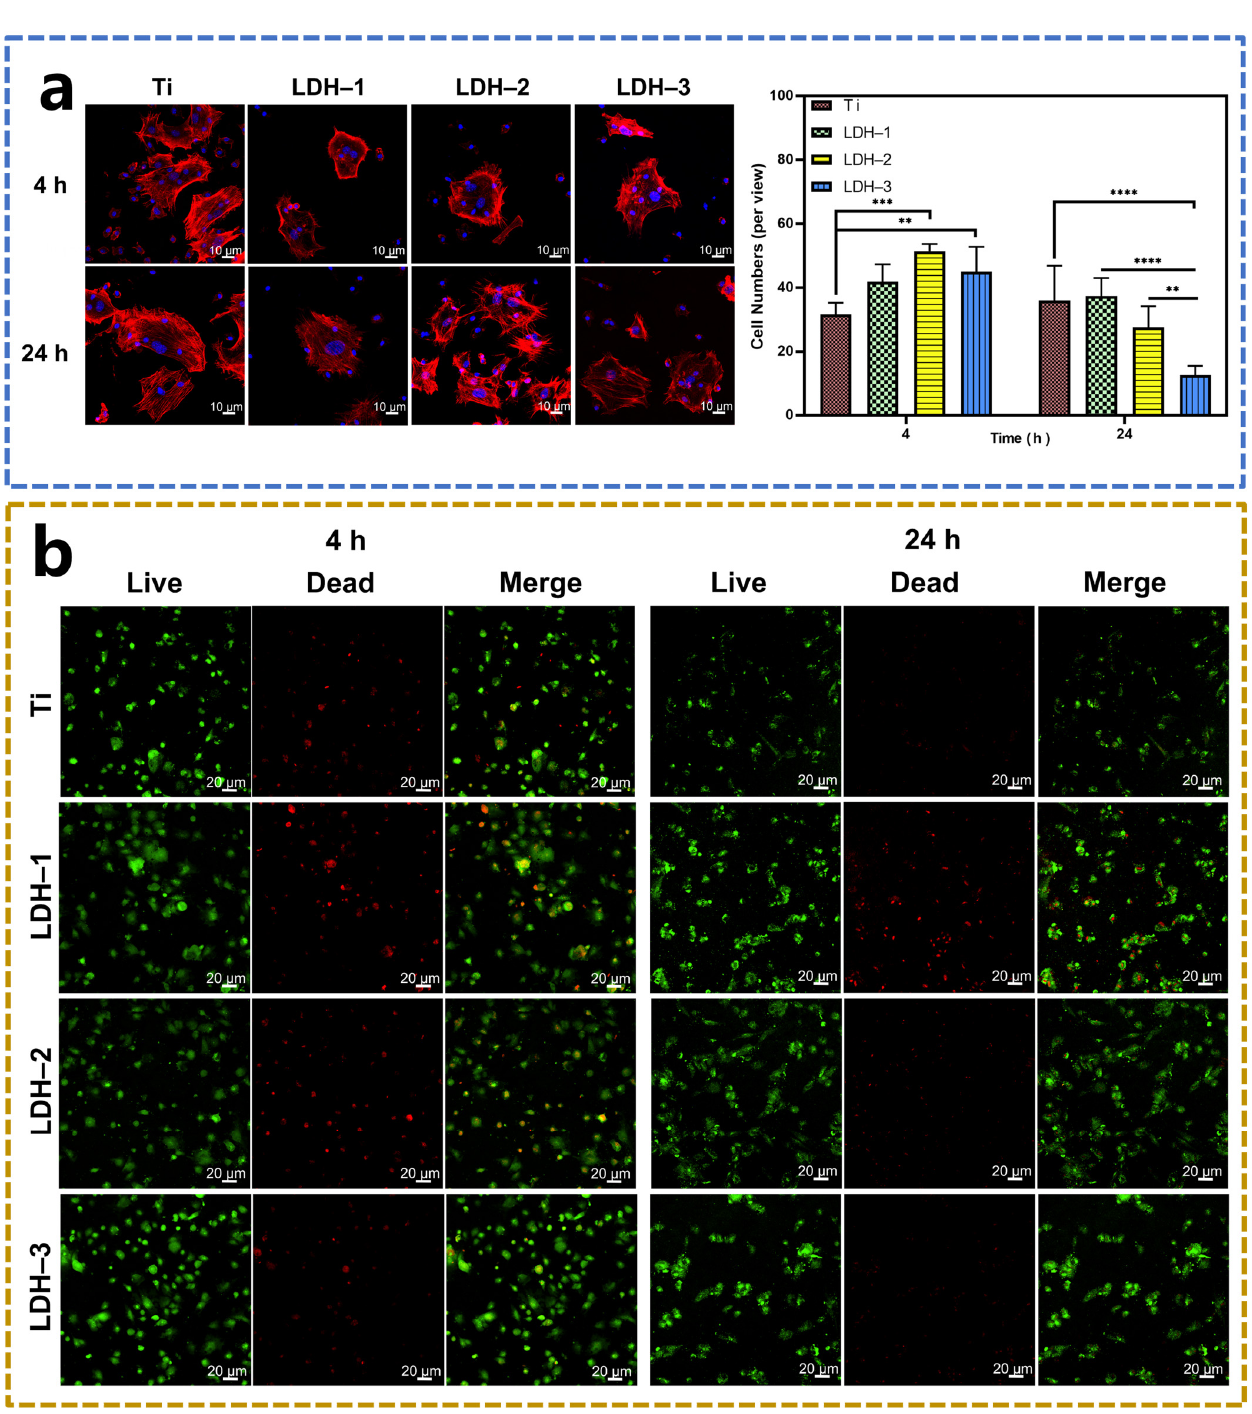
Figure 4. ( a ) Fluorescent confocal images of BMMSCs cultured on Ti, LDH − 1, LDH − 2, and LDH − 3 sample surfaces for 4 and 24 h with F-actin stained with TRITC phalloidin (red) and nuclei stained with DAPI (blue); ( b ) fluorescent confocal images of the live (green)/dead (red) staining of BMMSCs cultured on Ti, LDH − 1, LDH − 2, and LDH − 3 sample surfaces for 4 and 24 h. (** p < 0.01, *** p < 0.001, **** p < 0.0001)